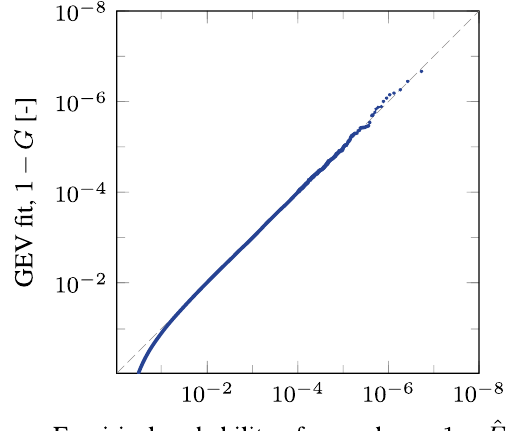
Figure 5. Histogram of the sampled wind speeds, where the dashed